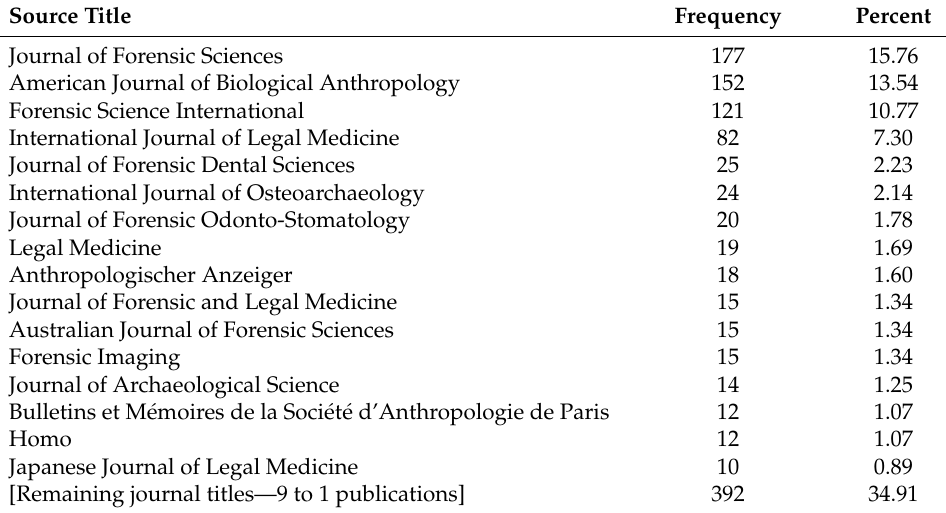
Table 2. Frequency and percentage of publications per journal in